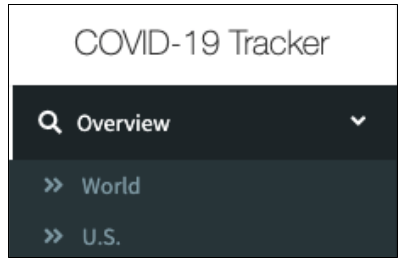
Figure 5. Two Subpages of the Overview